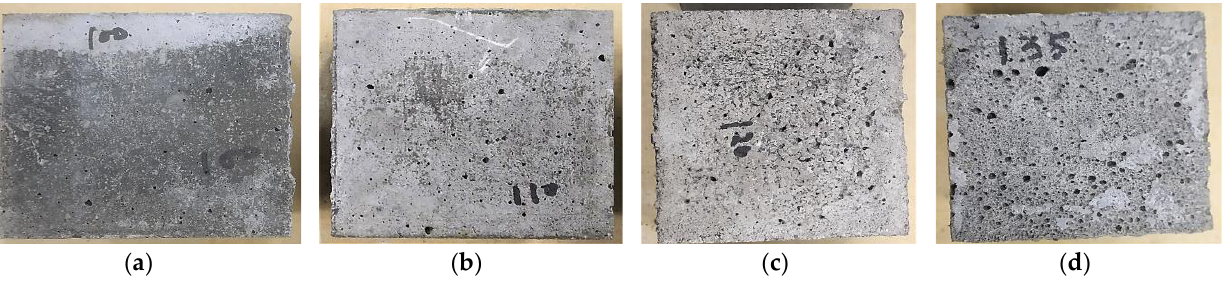
Figure 10. Geopolymer material specimens using preheated sand: ( a ) preheated sand at 100 °C; ( b ) preheated sand at 110 °C; ( c ) preheated sand at 120 °C; ( d ) preheated sand at 135 °C.